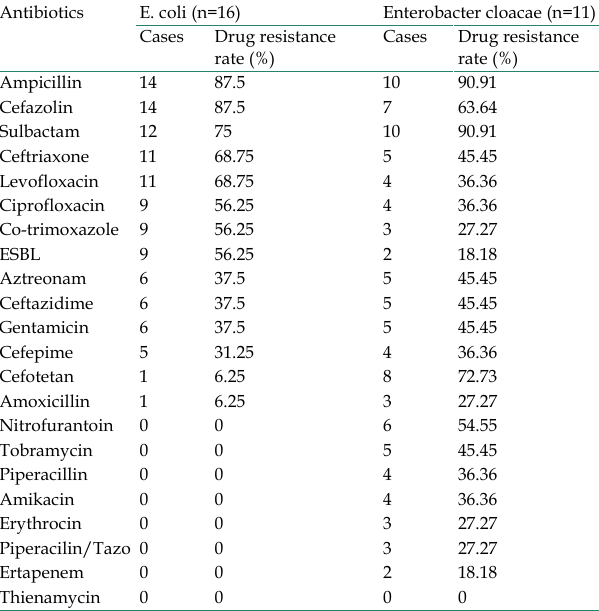
Table 7. The rate of drug resistance of the main Gram-negative bacteria